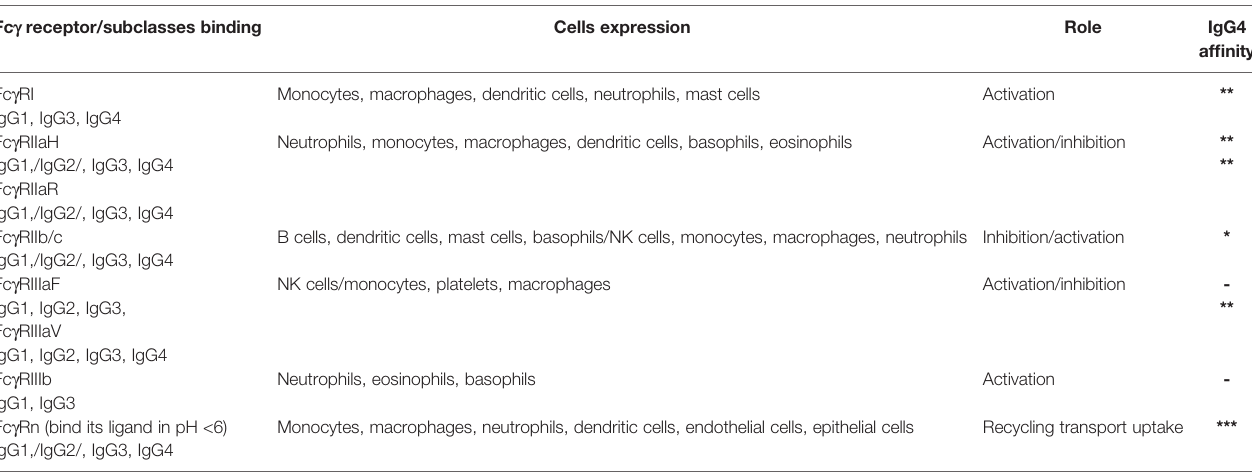
TABLE 1 | The main types and roles of Fc g Rs and its af fi nity of IgGs (13 – 17). Fc g receptor/subclasses binding Cells expression Role